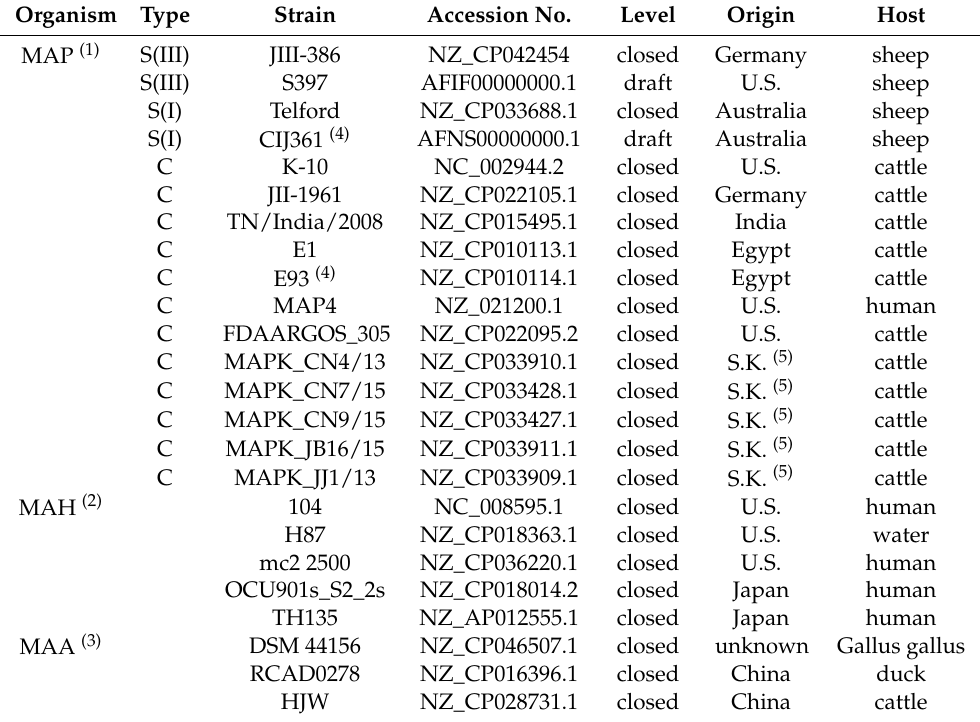
Table 1. Mycobacterium avium (M. a.) strains (n = 24) of different geographic and host origin whose NCBI reference genome sequences and annotations (all annotated by the NCBI PGAP pipeline) were involved in this